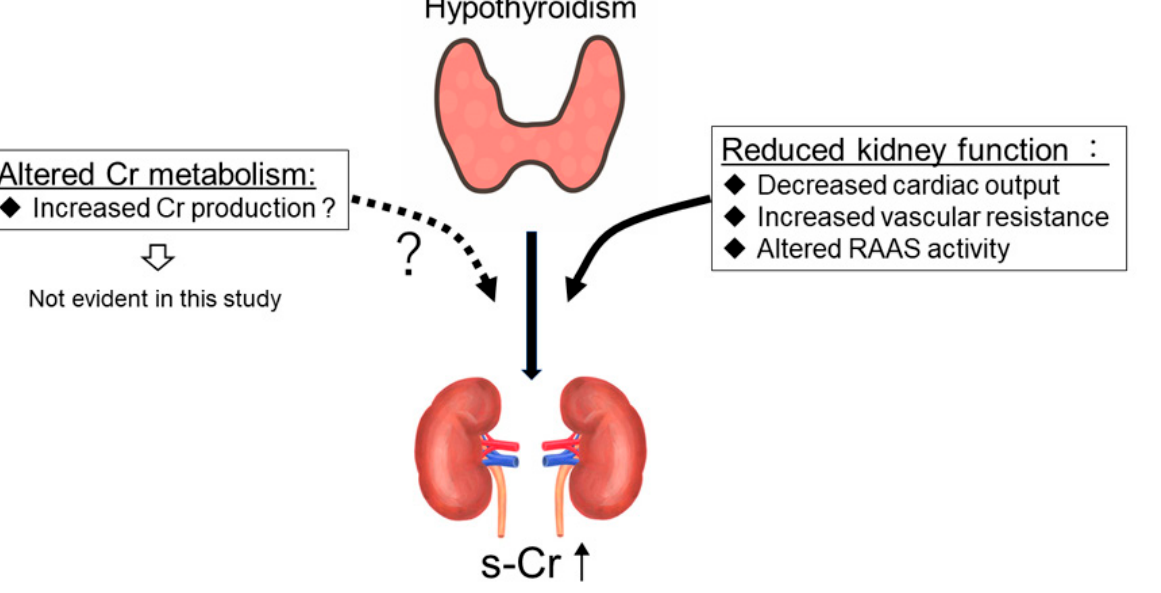
Figure 4. The mechanisms influencing serum creatinine levels under hypothyroidism. Cr, creatinine; s-Cr, serum creatinine; RAAS, renin–angiotensin–aldosterone system.